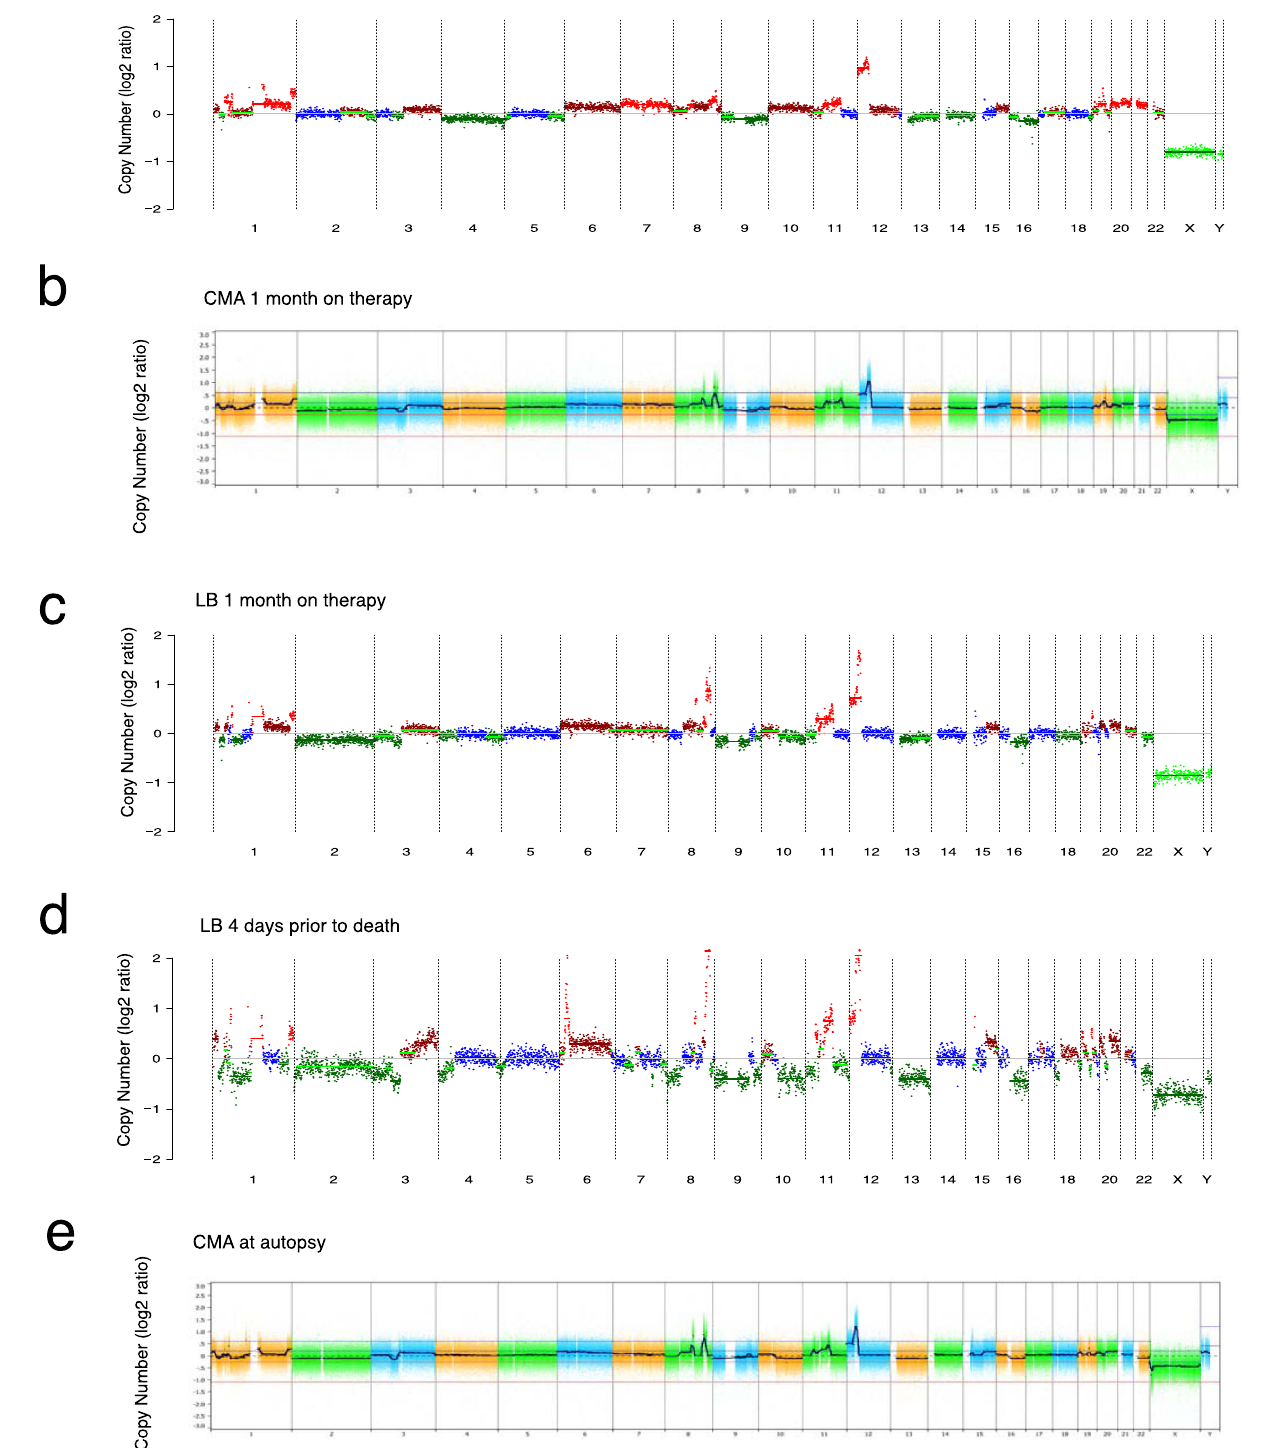
Fig. 4 Treatment response monitoring using liquid biopsy in a germ cell tumor case. a CNA pro fi le of ctDNA from plasma at diagnosis (patient 69) revealing complex abnormalities affecting almost all chromosomes with notable 12p gain. The calculated TFx was 16%. b Chromosomal microarray analysis of a pleural fl uid sample with similar complex abnormalities and high-level gain of 12p. c CNA pro fi le of plasma LB one month later, post cycle two of chemotherapy. The CNAs were detected for all chromosomes. The calculated TFx was 20%. d CNA pro fi le of LB sample 3 months after diagnosis and one month before death. All CNAs were still detectable in the plasma of this patient with an additional high-level gain of 6p. The calculated TFx was 47%. e CMA plot at autopsy depicting highly complex CNAs affecting all chromosomes, but without the gain in 6p. For each serial sample, the estimated ichorCN log2 ratio is plotted on the y-axis, and chromosomes 1-22, X, and Y are shown on the x-axis. Red indicates CN gain, blue indicates CN neutral, and green indicates CN